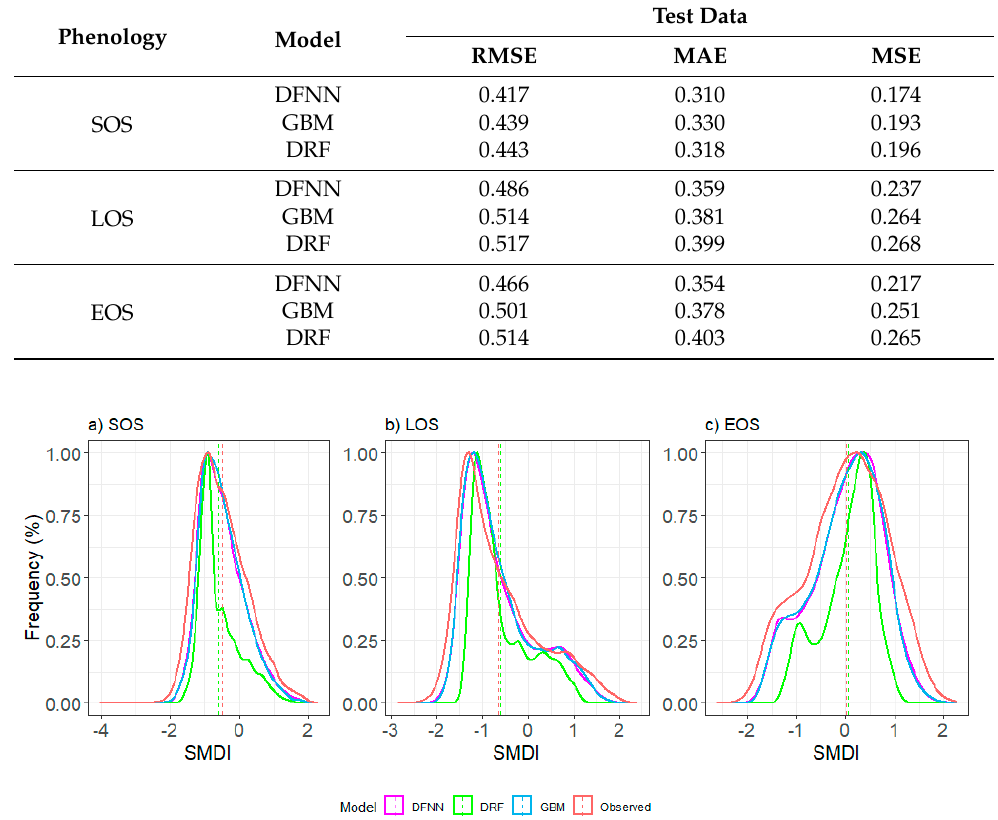
Figure 7. Frequency distribution of SMDI based on deep learning and machine learning model during SOS, LOS and EOS stage. The vertical line expressed the mean SMDI value.